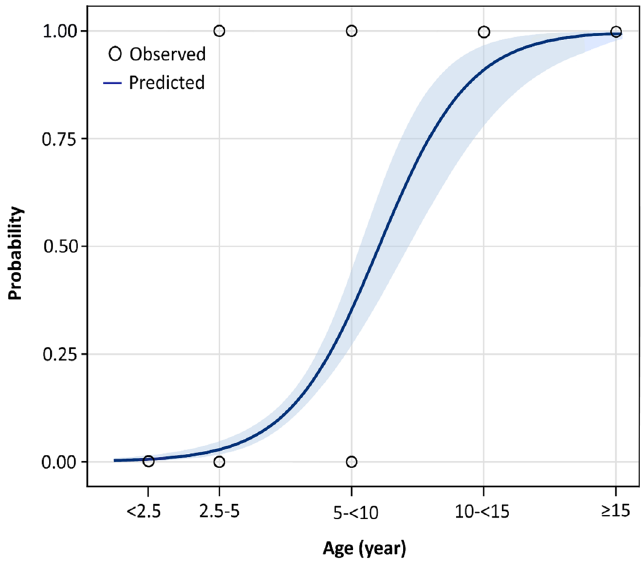
Figure 3. Probability plot for the ability of age to predict the seroprevalence of West Nile virus (WNV) infection in the Nile Delta horses in Egypt. The curve shows the likely probability of seropositive WNV associated with age, with the 95% shaded blue confidence